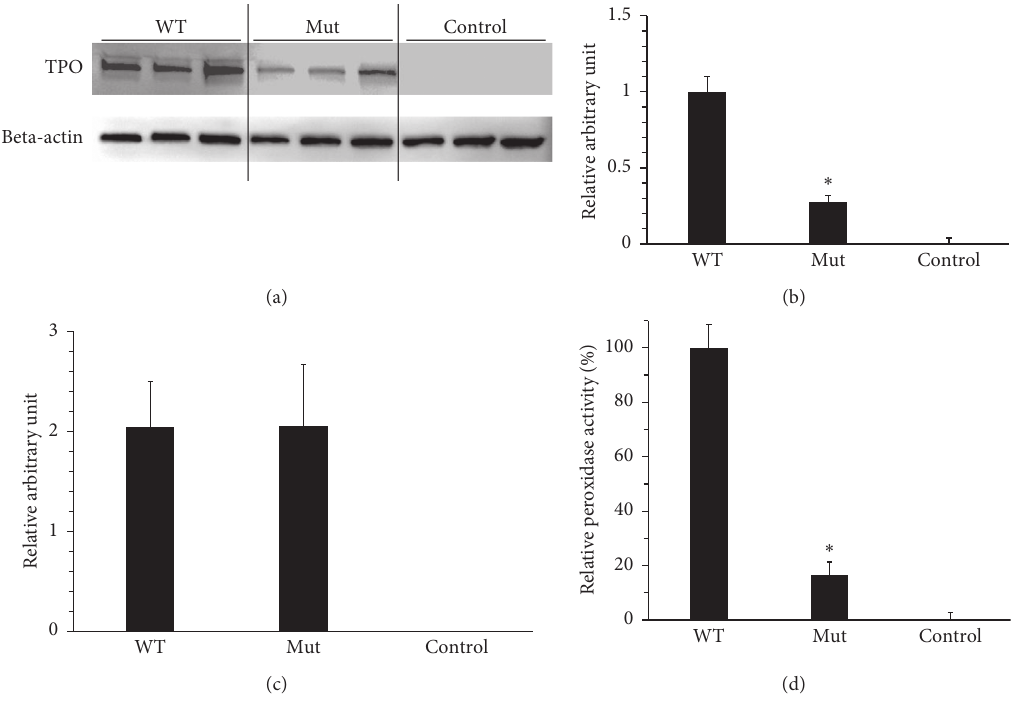
Figure 4: Functional analyses of the identified novel TPO mutation. Protein expression levels of TPO (WT or Mut) were assessed using Western blotting with a monoclonal anti-TPO antibody. (a) The upper bands denote TPO proteins (103kD). Monoclonal anti-beta-actin antibodies were used as the loading control. The lower bands denote beta-actin proteins (42 kD). Western blots were performed in triplicate. (b) Each TPO expression signal was expressed in relative arbitrary unit after normalizing against beta-actin (TPO/beta-actin ± SEM). Wild- type TPO expression level was set to 1, and control TPO expression level was set to 0. The mutant TPO expression level was significantly lower than that of the wild type ( n � 3, Student’s t test, ∗ P < 0 . 05). (c) The results of quantitative PCR performed using SYBR Green were shown in arbitrary units of TPO mRNA/housekeeping gene hprt1 as the mean ± standard error of the mean. There was no significant difference between wild-type and mutant TPO mRNA expression ( n � 5, Student’s t test, P � 0 . 990). Measurement of peroxidase activity using Amplex Red reagent. (d) Peroxidase activity of mutant TPO protein (Mut) was normalized to that of the wild type (WT; 100%) and that of the mock-transfected (control; 0%). The results of three independent experiments are expressed as the mean ± standard error of the mean. ∗ P < 0 . 05, Student’s t -test (Mut vs